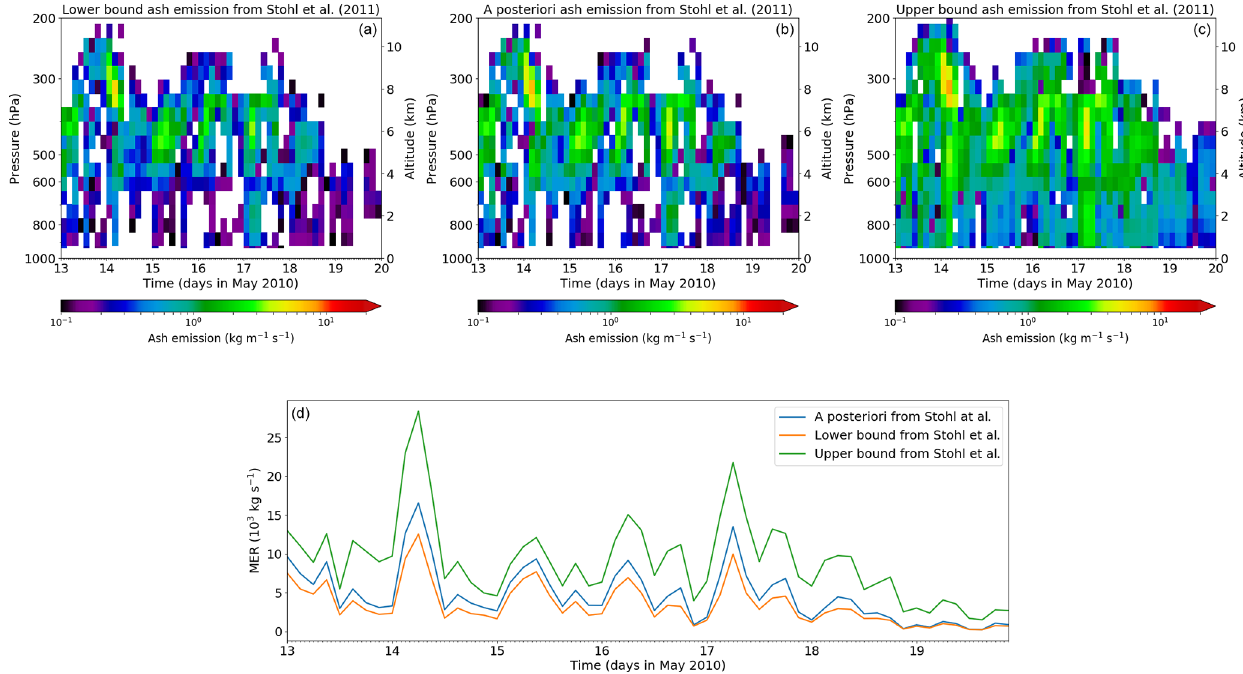
Figure 2. (a–c) A posteriori source terms derived from Stohl et al. (2011): lower bound, best estimate, and upper bound (from left to right). The source terms of fine ash are expressed in kgm − 1 s − 1 and are shown as a function of time and height. (d) Mass eruption rate (unit kgs − 1 ) for the three source terms, as a function of